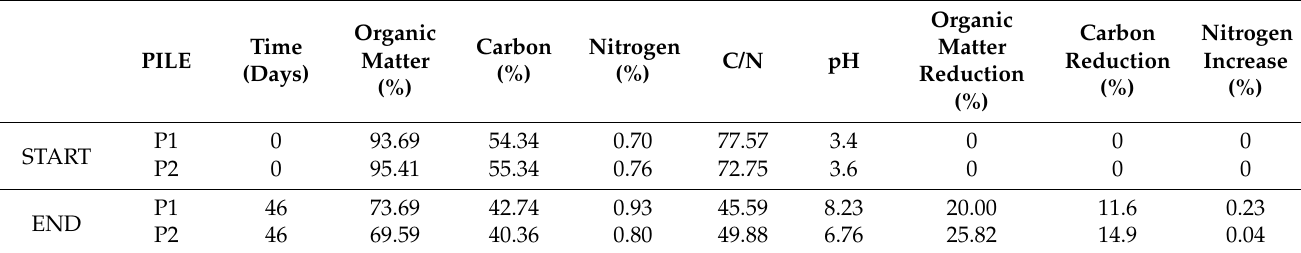
Table 6. Overall results of the indirect indicators of microbial activity during biodrying of waste piles.